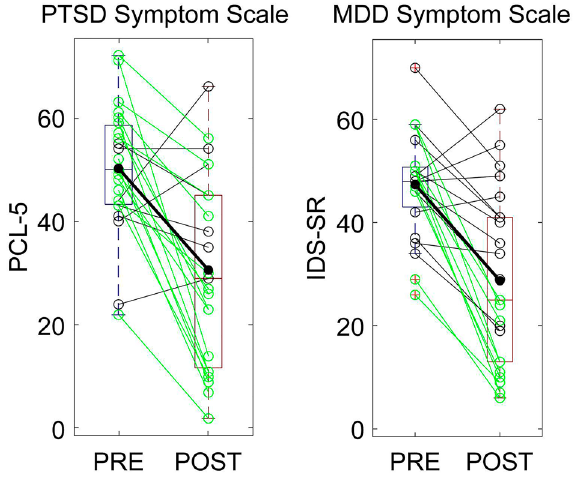
Figure 2. Clinical score change pre- (blue) to post-treatment (red) for all patients. Scores reported for the PTSD symptom scale (PCL-5, left) and the MDD symptom scale (IDS-SR, right) for patients with a clinical response (green) and without (black) as well as the group average